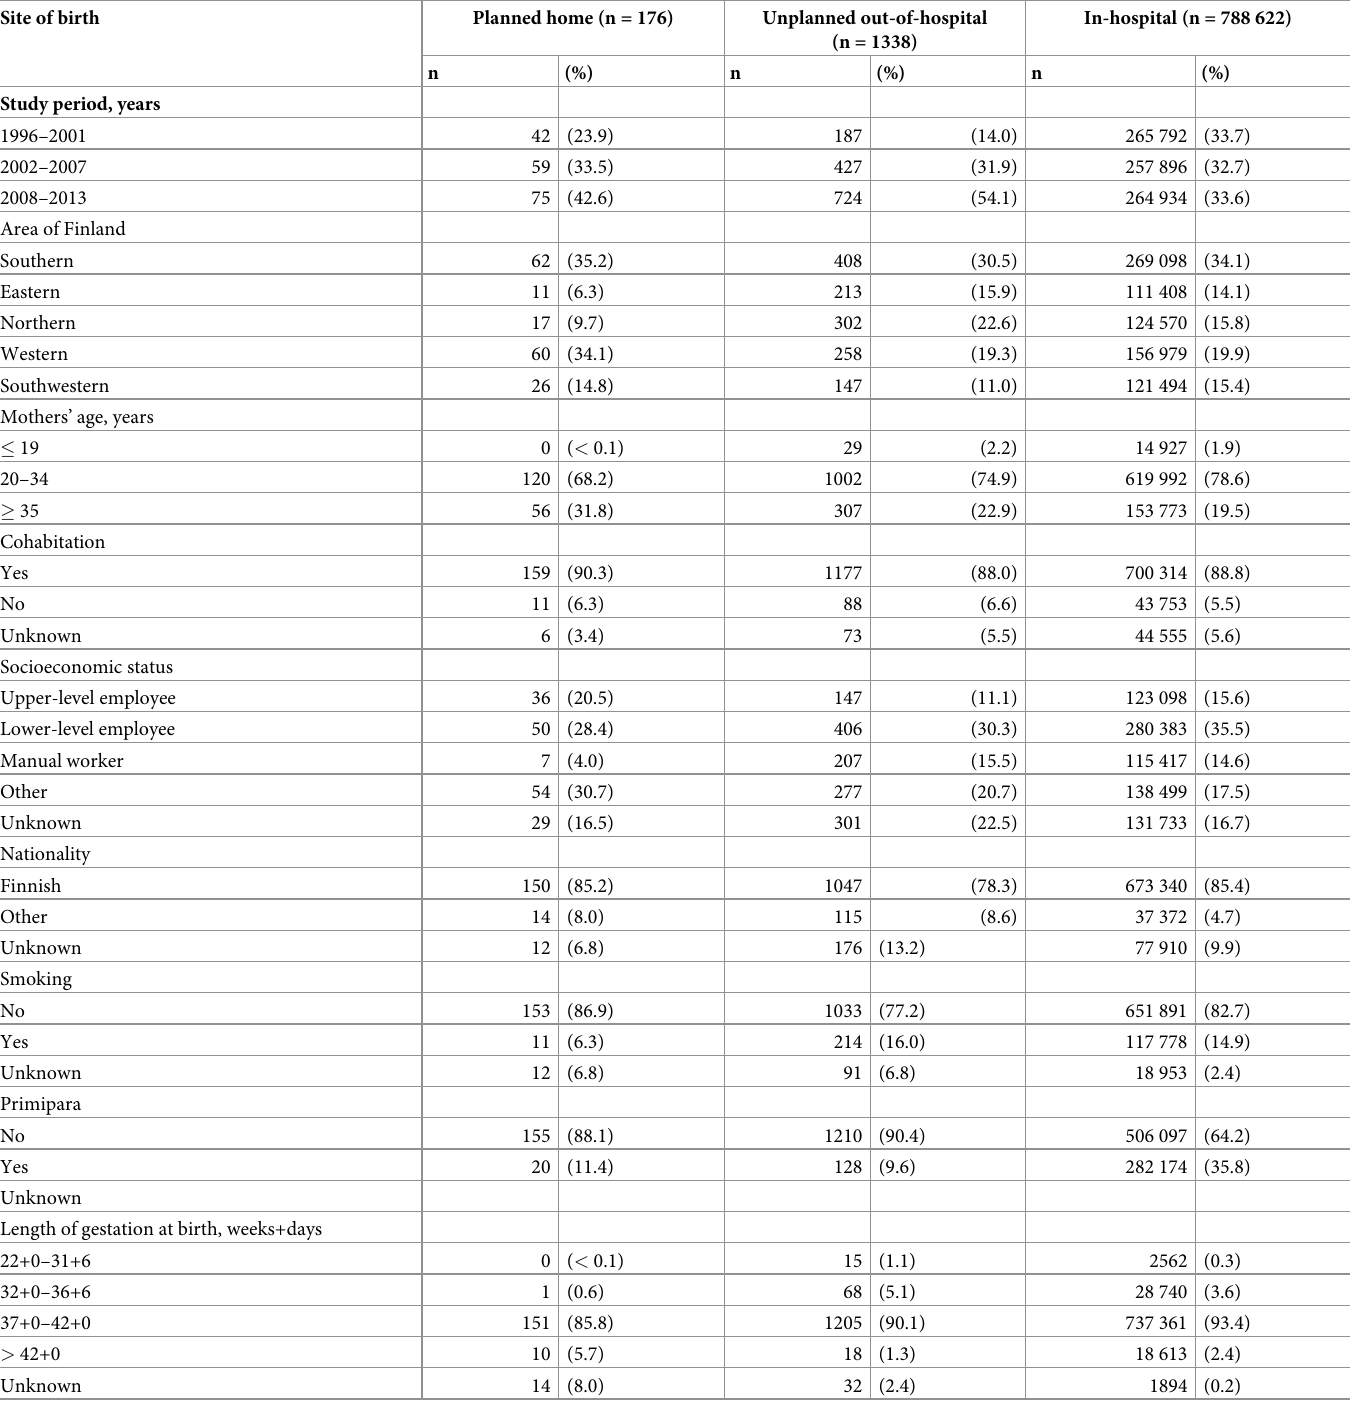
Table 1. Characteristics of mothers (n = 790